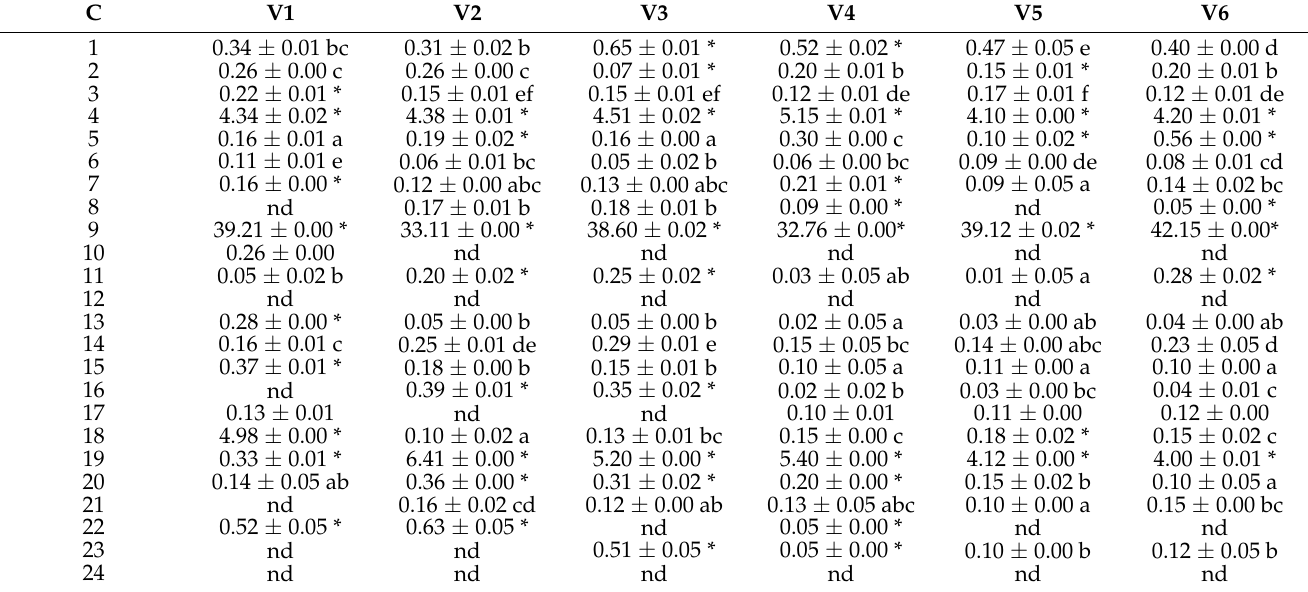
Table 3. Final proportion of identified volatile compounds in Sauvignon blanc wines (% of total